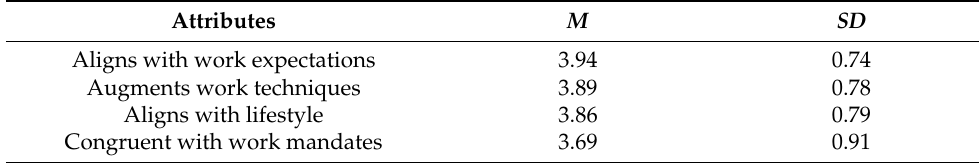
Table 3. Compatibility’s Innovation Metrics ( n = 334).